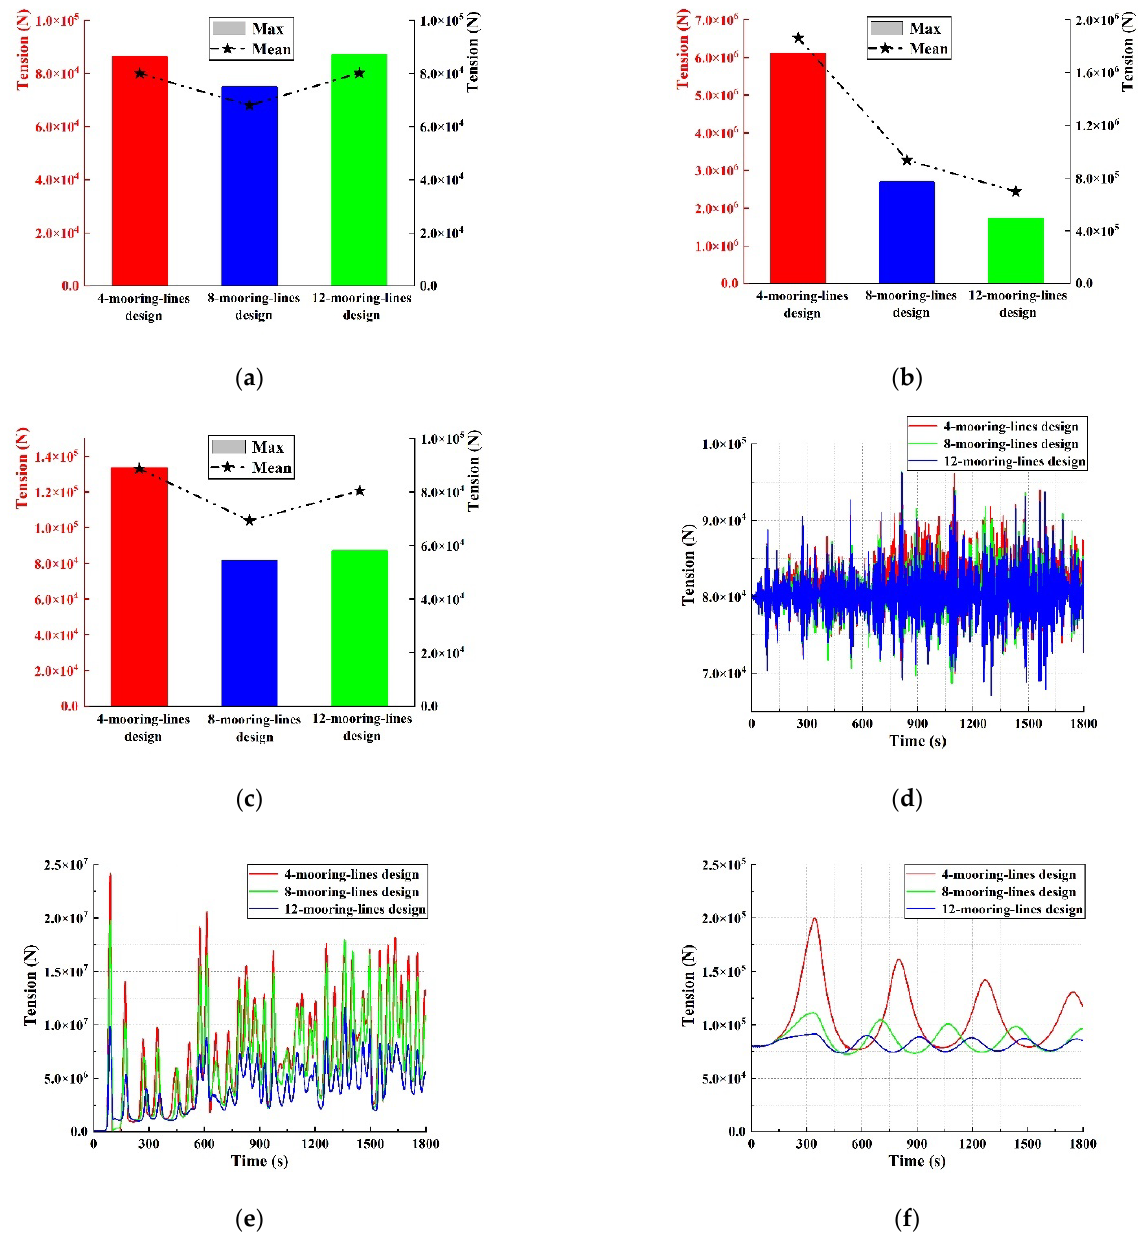
Figure 16. Influence of the number of mooring lines on mooring line tension. ( a ) Maximum and mean values of mooring system tension under wave loads; ( b ) maximum and mean values of mooring system tension under level ice loads; ( c ) maximum and mean values of mooring system tension under broken ice floes loads; ( d ) the tension of mooring line 1 under wave loads in time-domain analysis; ( e ) the tension of mooring line 1 under level ice loads in time-domain analysis; ( f ) the tension of mooring line 1 under broken ice floes loads in time-domain analysis.